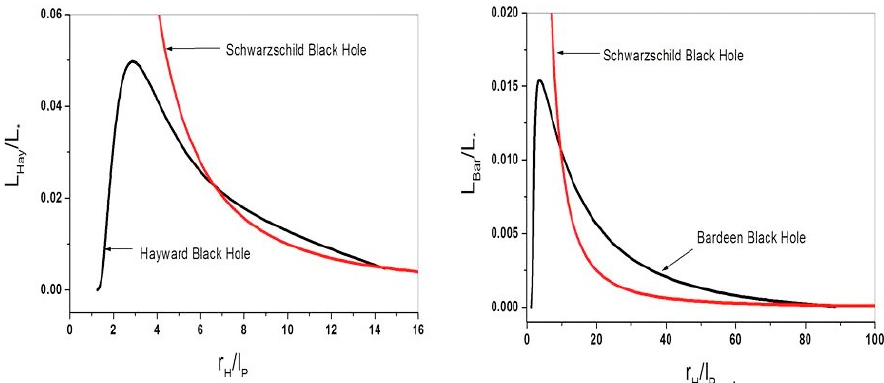
Figure 3. Normalized luminosities for the Bardeen ( left panel) black hole and the Hayward ( right panel) black hole as a function of the horizon radius in units of the Planck distance scale.